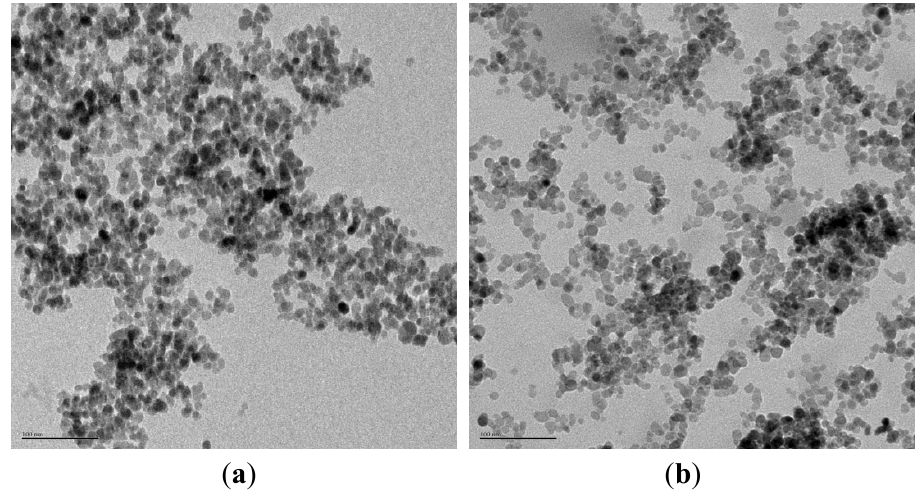
Figure 1. Transmission Electron Microscopy (TEM) micrographs of base catalysts supported on magnetite nanoparticles: ( a ) MNP-NH scale bar 100 nm.